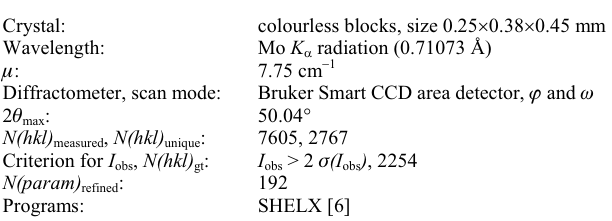
Table 1. Data collection and handling.